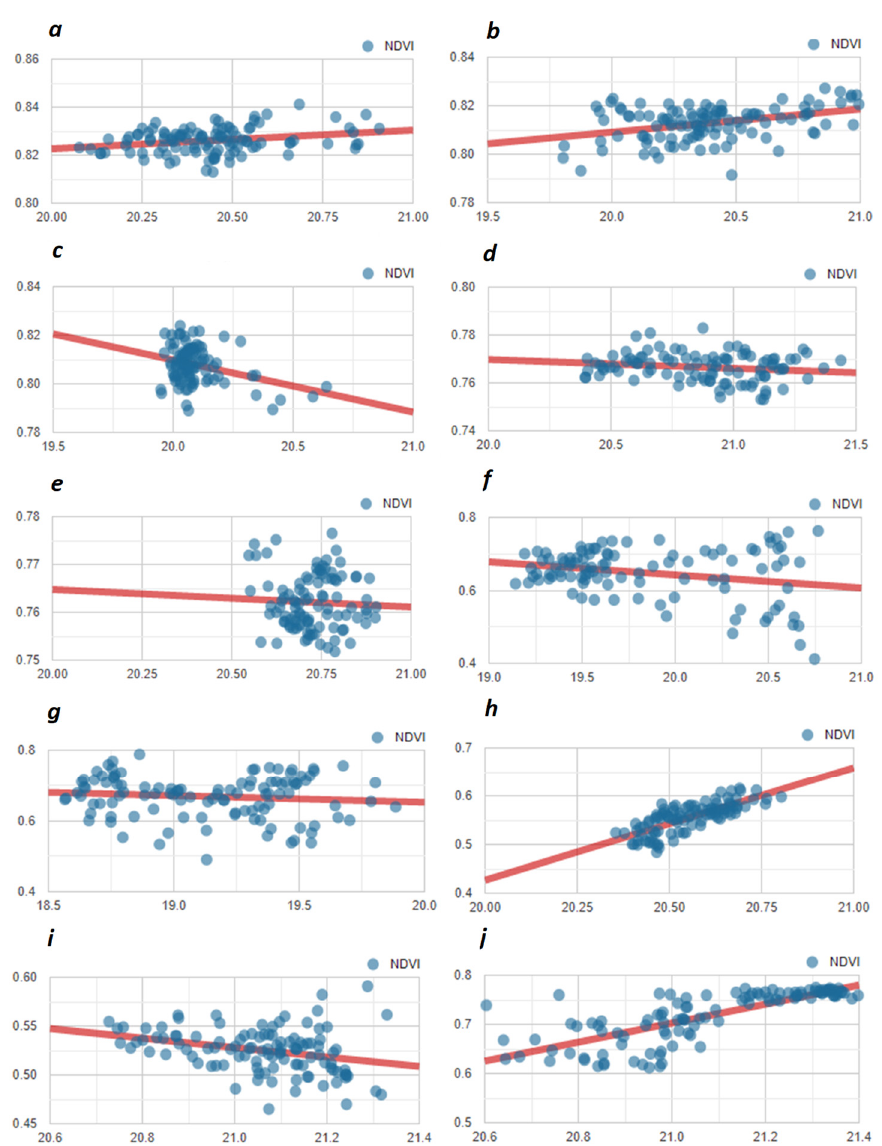
Figure 10. Relationship between NDVI and nighttime LST (°C) values in forested and deforested areas in the Chiquitania region (2001–2021). The red line represents the trend line of the data points. Sites with intact forest: ( a ) Noel Kempff, ( b ) Bajo Paraguá, ( c ) Monteverde, ( d ) San Rafael, and ( e ) Tucabaca. Sites with deforestation: ( f ) San Ignacio, ( g ) Concepción, ( h ) El Cerro/California, ( i ) Nueva Esperanza, and ( j ) Santa Ana/Buena Vista.